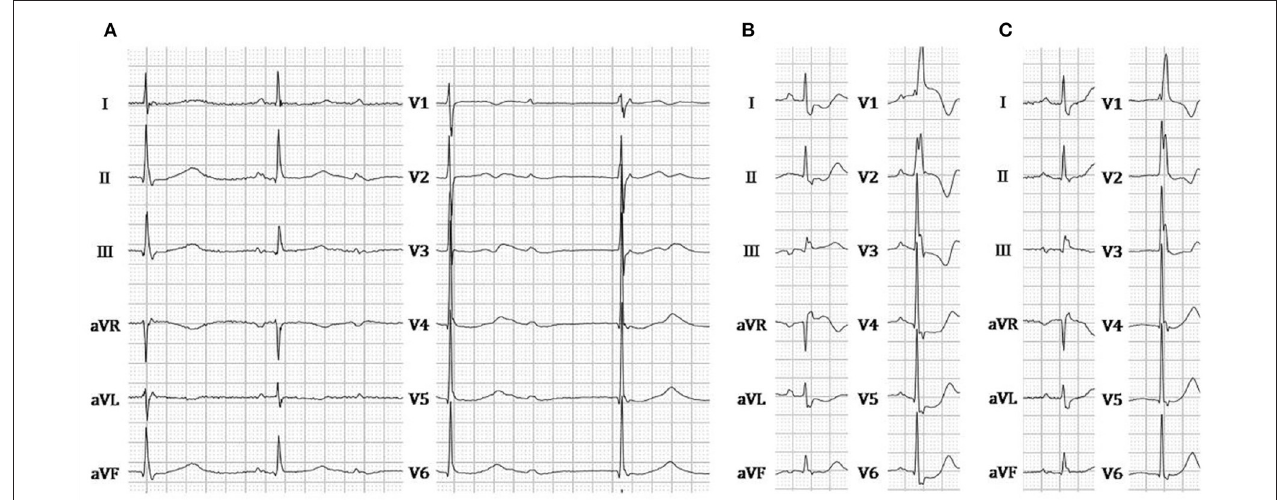
FIGURE 2 | (A) ECG during intrinsic rhythm. (B) ECG recorded when chest pain occurred. (C) ECG recorded when chest pain was relieved. ECG, electrocardiogram.